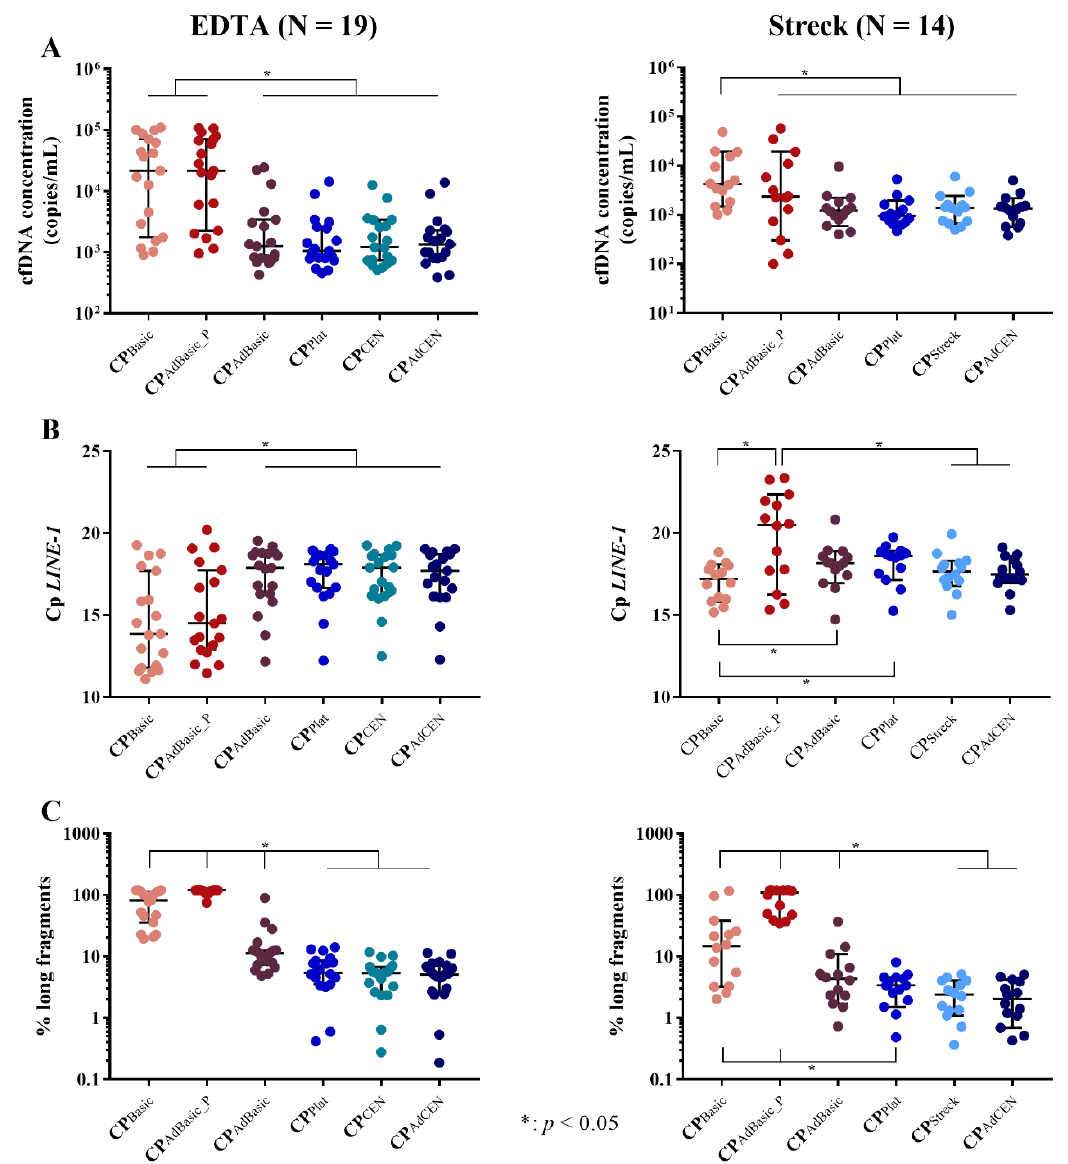
Figure 1. Comparison of total cfDNA yield per centrifugation protocol in EDTA and Streck tubes. In all samples, ( A ) digital droplet PCR (ddPCR) (copies/mL) and ( B ) LINE-1 82 bp quantitative PCR (qPCR) were performed to determine total cfDNA concentration, as well as ( C ) cfDNA integrity analysis by qPCR to determine the percentage of long (> 400 bp) fragments; N: number of participants.